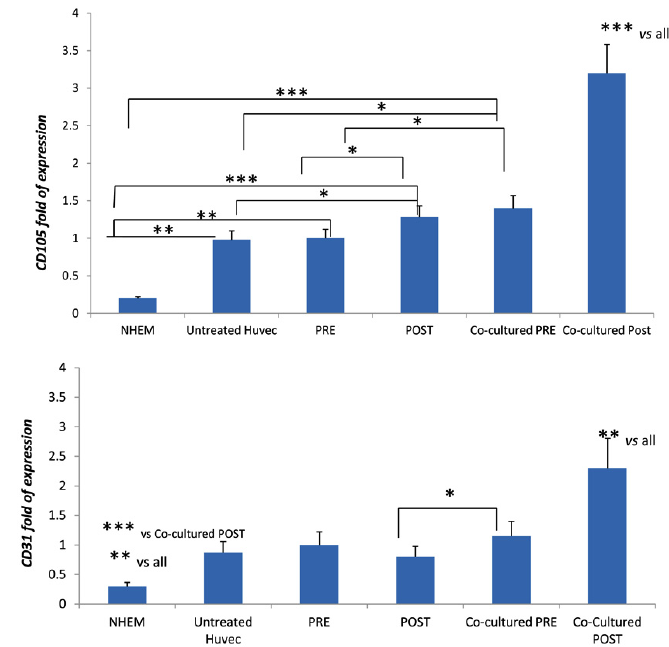
Figure 4. CD105 and CD31 markers; expression in HUVECs in the presence of sera collected from patients before (pre) and after (post) three months of DOAC treatment. The sera (pre or post treatment) were added in HUVEC co-cultured with MSCs. NHEM: normal melanocytes used as low expressing cells. * p < 0.05; ** p < 0.01; *** p < 0.005.